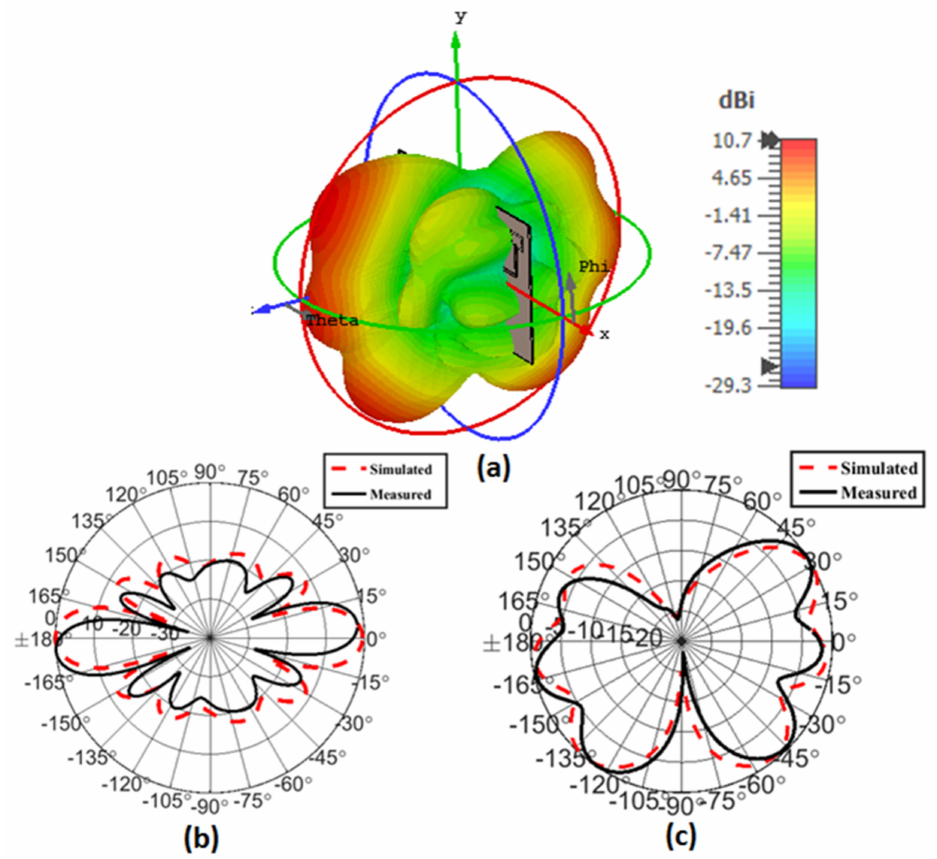
Figure 10. Radiation pattern of the 1 × 4 antenna array at 28 GHz; ( a ) 3D, ( b ) normalized pattern @ XZ-plane, and ( c ) normalized pattern @